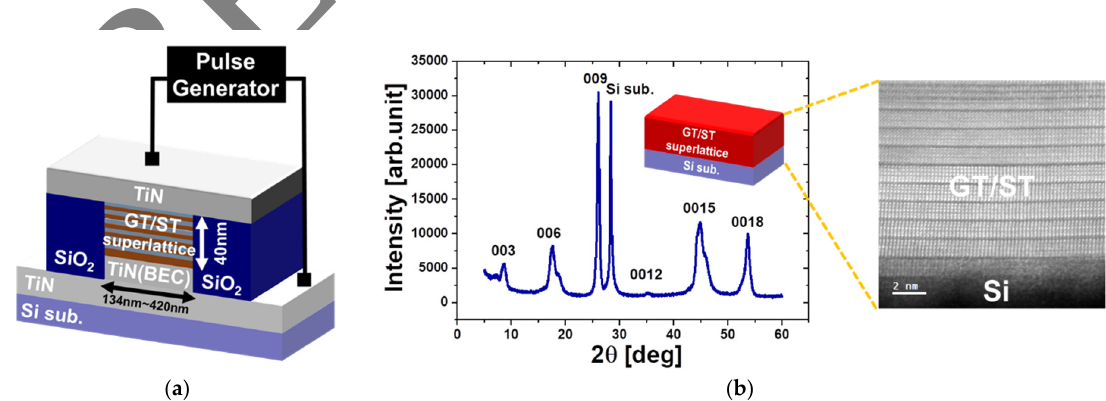
Figure 1. ( a ) Schematic of the fabricated GeTe/Sb 2 Te 3 (GT/ST) interfacial phase-change memory (iPCM) structure, ( b ) XRD diffraction pattern of a GT/ST SL (SL) structure and cross-sectional TEM image of the GT/ST superlattice on an Si (111) substrate.